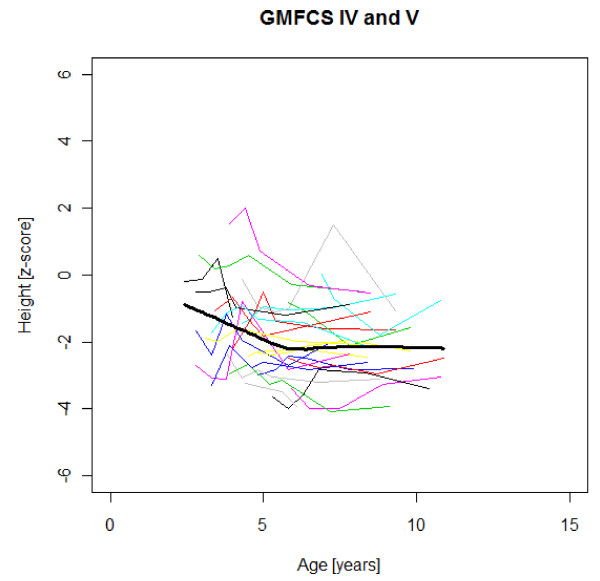
Height z-scores in GMFCS IV-V. Height z-score at different age in 24 children with CP spastic diplegia, GMFCS IV-V. Their mean z-score development with age is shown in black.